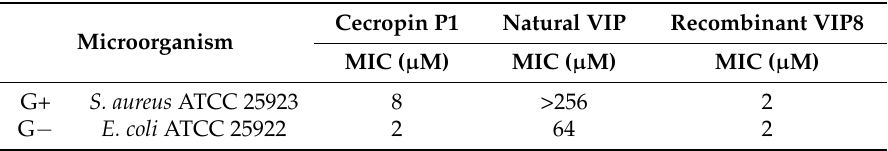
Table 3. Antimicrobial activities of recombinant VIP8 a